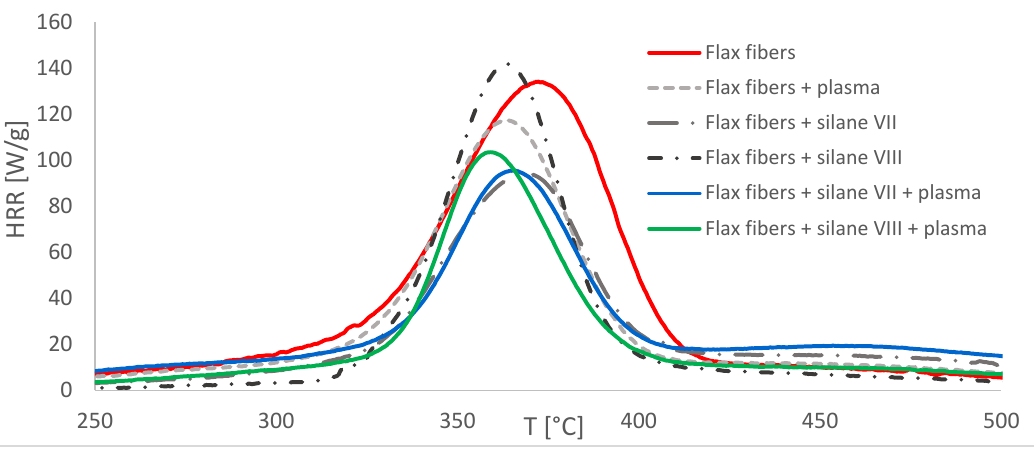
Figure 3. PCFC results for unmodified and modified fibers.